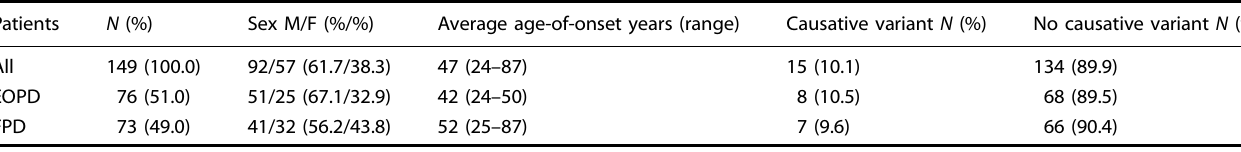
Table 1. Patient ’ s characteristics. Patients